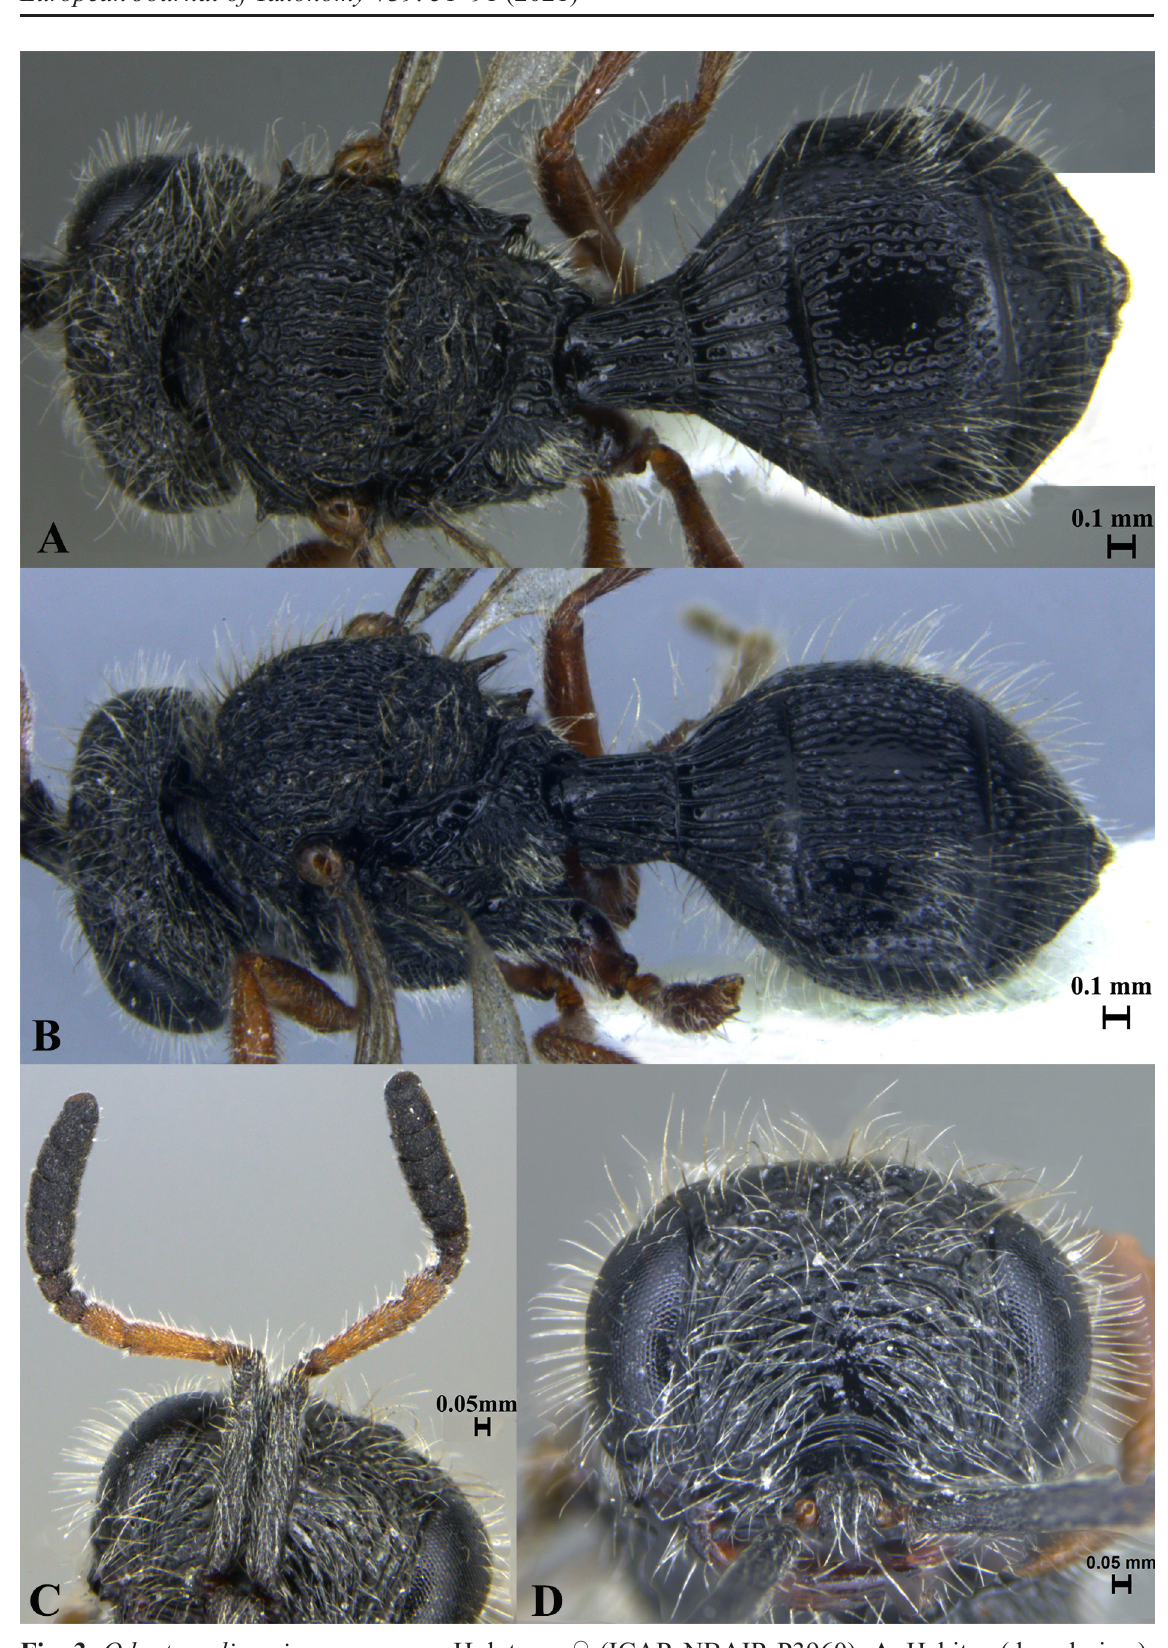
Fig. 3. Odontoscelio spinosus sp. nov. Holotype, ♀ (ICAR-NBAIR P3960). A . Habitus (dorsal view). B . Habitus, showing axillular spines. C . Antennae. D .